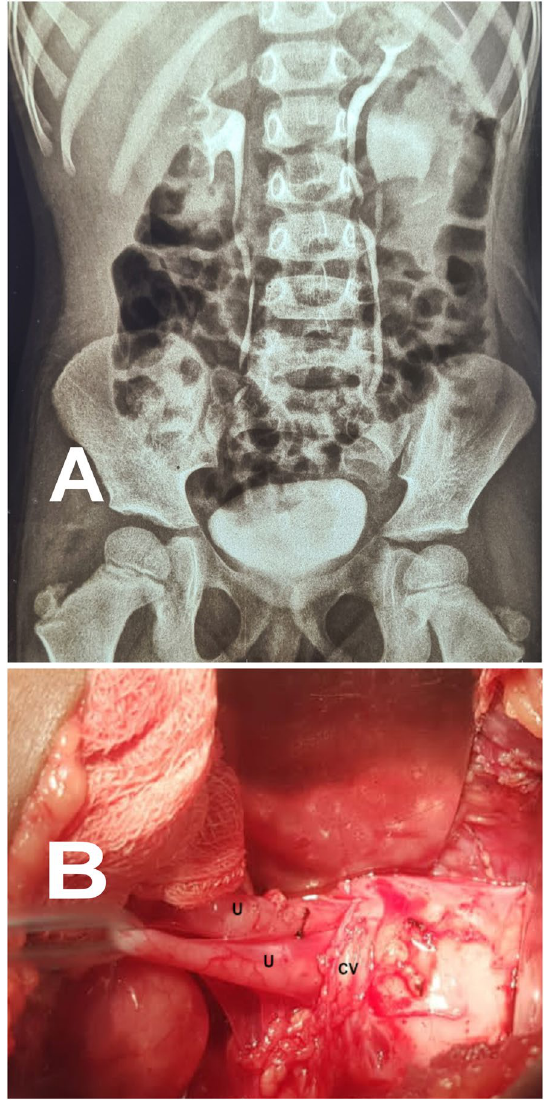
Fig. 6 A IVP image showing lower moiety hydronephrosis with PUJO. B Intraoperative image of the same patient demonstrating the crossing vessel causing lower moiety PUJO. Legend: U—ureters, CV—crossing